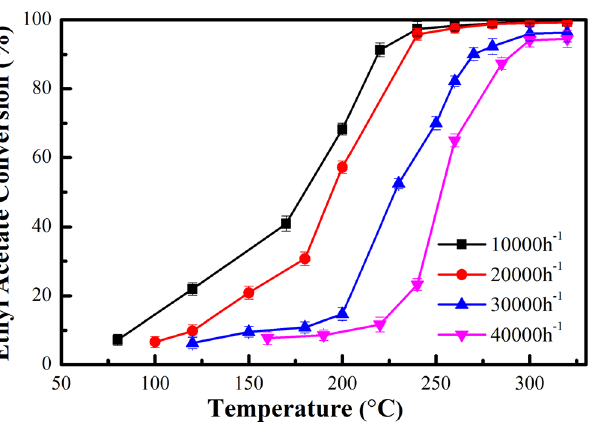
Figure 4. Catalytic removal efficiency of R-Ag/MnO 2 -cordierite on ethyl acetate at different space velocity; reaction conditions: VOCs = 1000 ppm; catalyst content = 0.1 g/cm 3 .